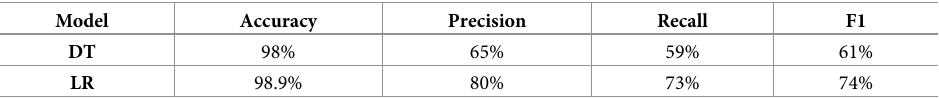
Table 5. Results of training on the original dataset.